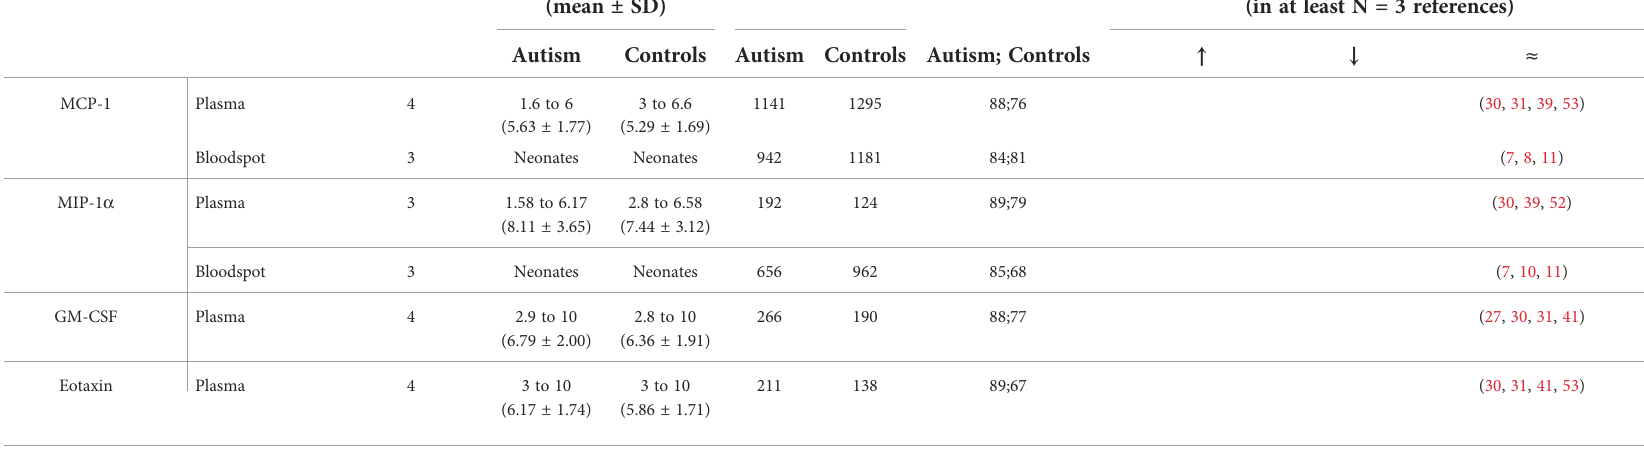
TABLE 2 Level of cytokines produced by blood immune cells of individuals with autism, compared with controls, at either baseline or after in vitro stimulation conditions. No. of % Males Reported fi ndings in autism compared Cytokine Cell type(s) Condition affected (Stimuli cell type ) Autism Controls Autism Controls Autism;